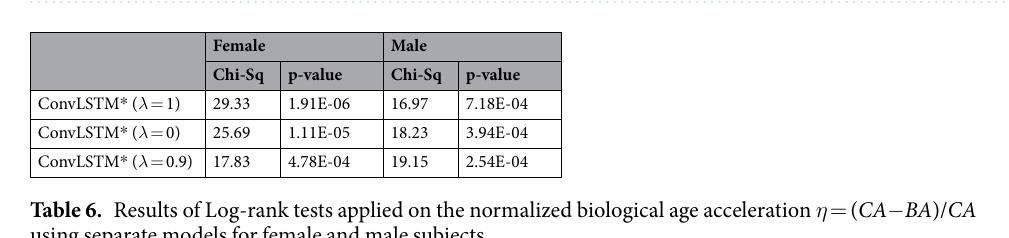
Figure 7. The Kaplan Meier curves for applying η = − CA BA Q1, Q2, Q3, and Q4 denote 1st, 2nd, 3rd, and 4th quartiles, respectively.